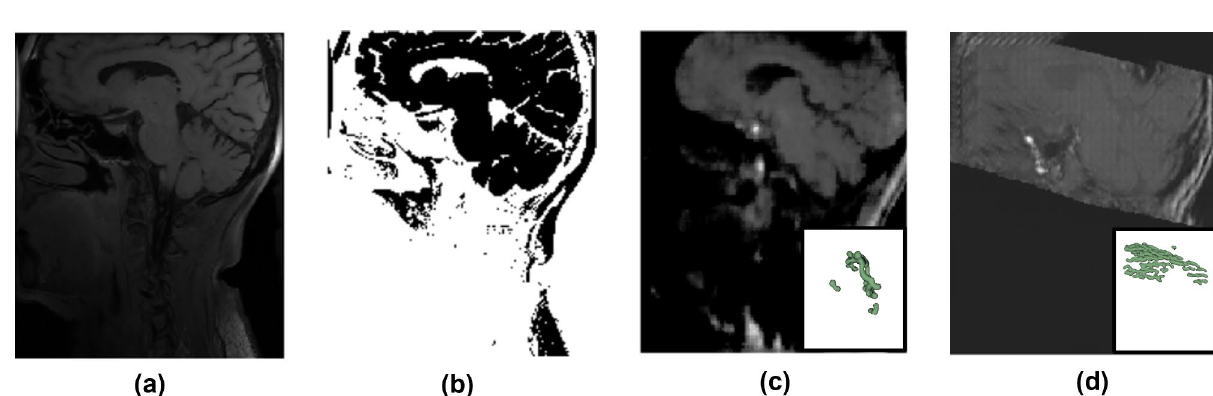
Figure 2. Challenges with vessel identification and failure of common direct segmentation or synthesis approaches. ( a ) VWI has low contrast and heterogenous signal strength, challenging vessel segmentation; ( b ) the Otsu algorithm fails to differentiate vessels from rest of the brain; the MRA-like image synthesized by ( c ) U-Net and ( d ) GAN all result in fragmented and inconsistent vessel